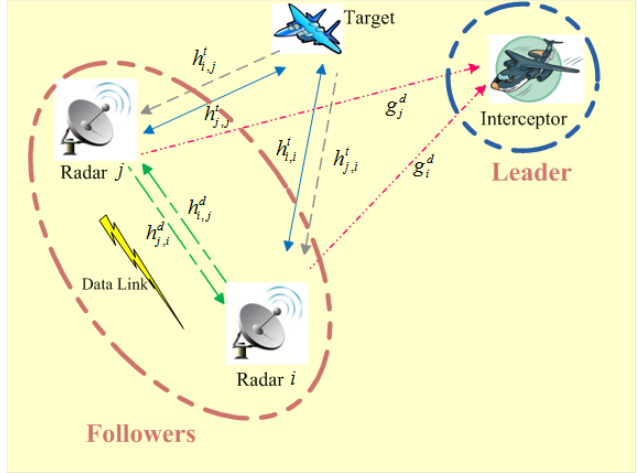
Figure 1. Illustration of the system